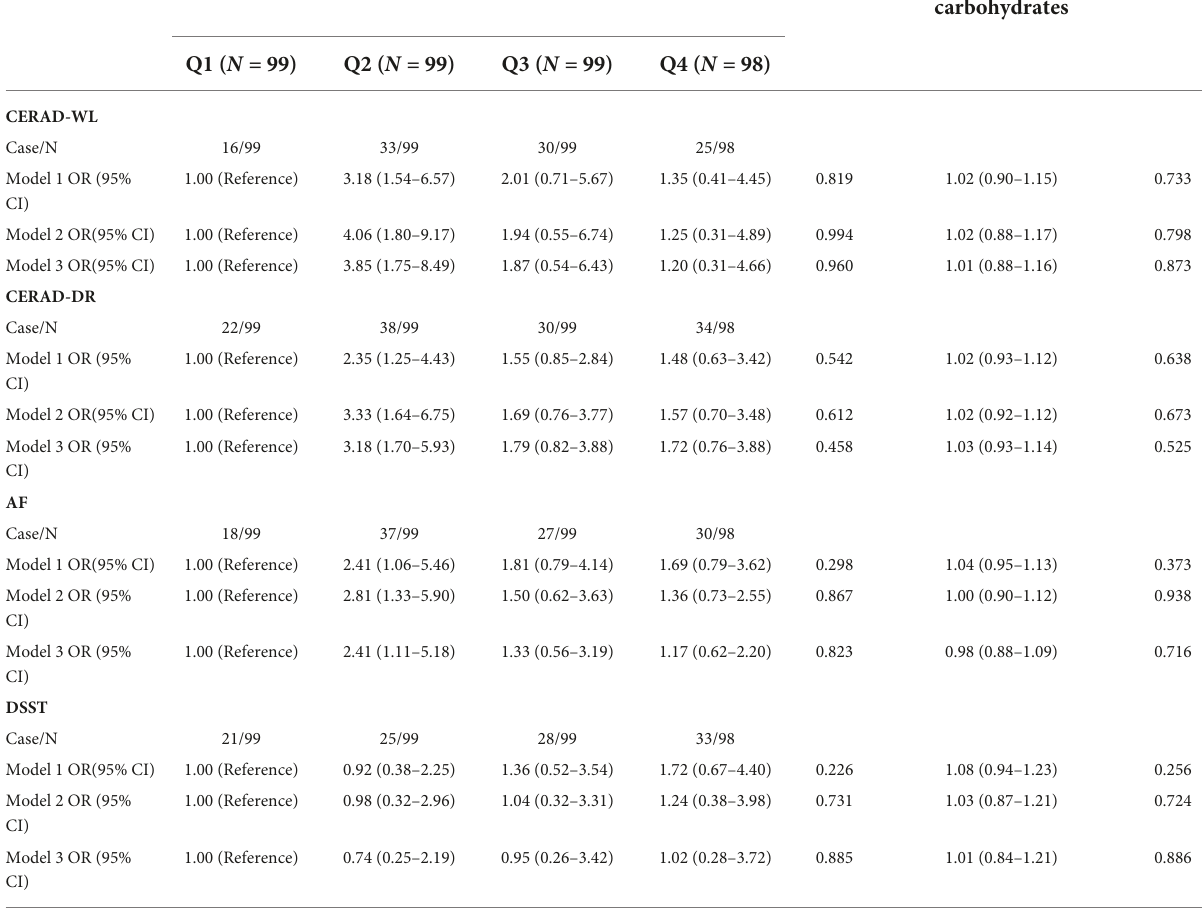
TABLE 3 Association of dietary carbohydrates with poor cognitive performance among participants whose daily fasting duration was more than 16